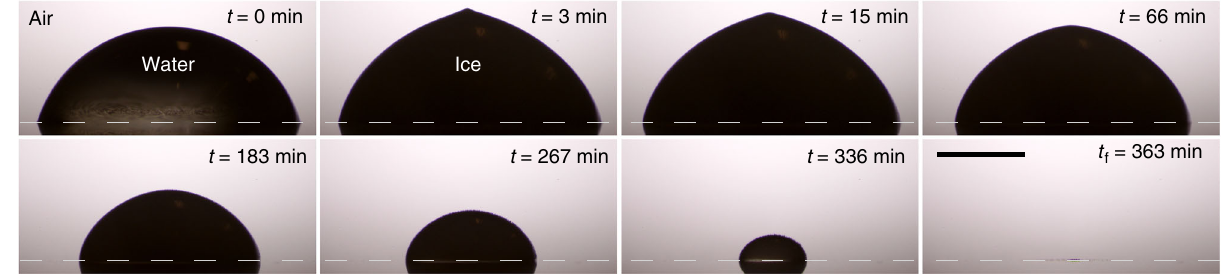
Fig. 2 Evaporation of a pointy ice drop. Sequence of images documenting the evaporation in air of a pointy ice drop of initial volume V 0 = 4.4 μ L on a cold surface ( T s = − 10 °C, RH = 4.8%; see Supplementary Movie 2). The pictures include the drop ’ s re fl ection on the substrate surface (highlighted by the dashed line). Scale bar